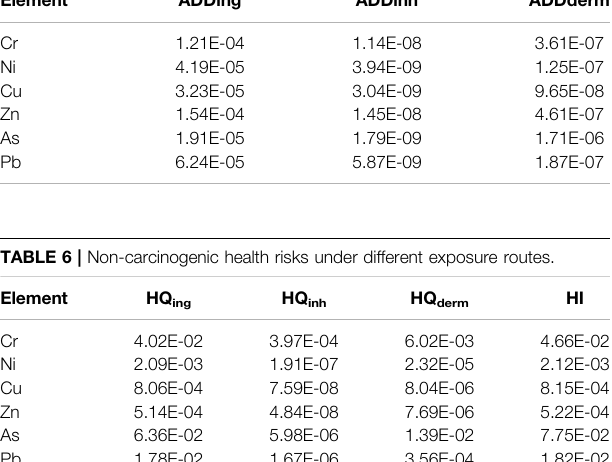
TABLE 5 | Average daily exposure dose from different exposure routes in Lushan scenic area. Element